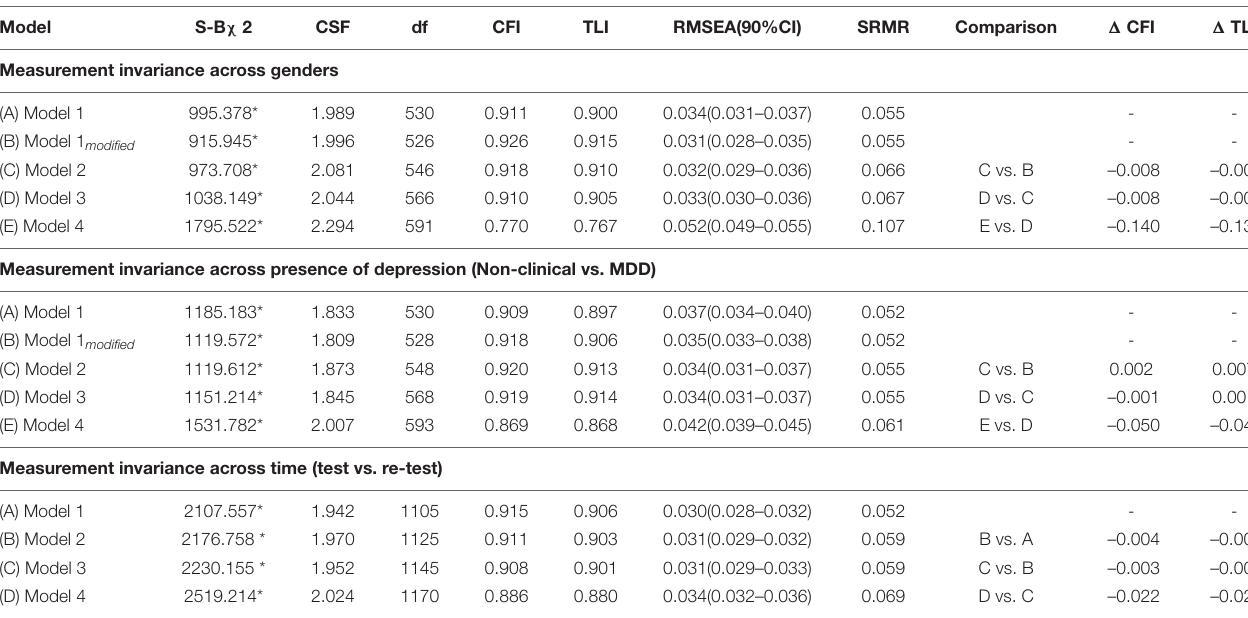
TABLE 10 | Measurement invariance of the